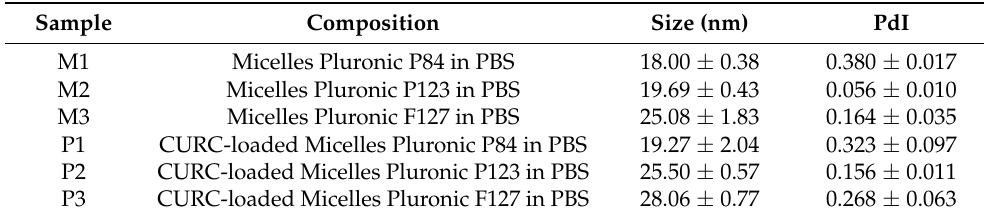
Table 4. Physico-chemical characteristics of Pluronic micelles with and without encapsulated Cur- cumin at 37 ◦ C (values are mean ± SD, n =